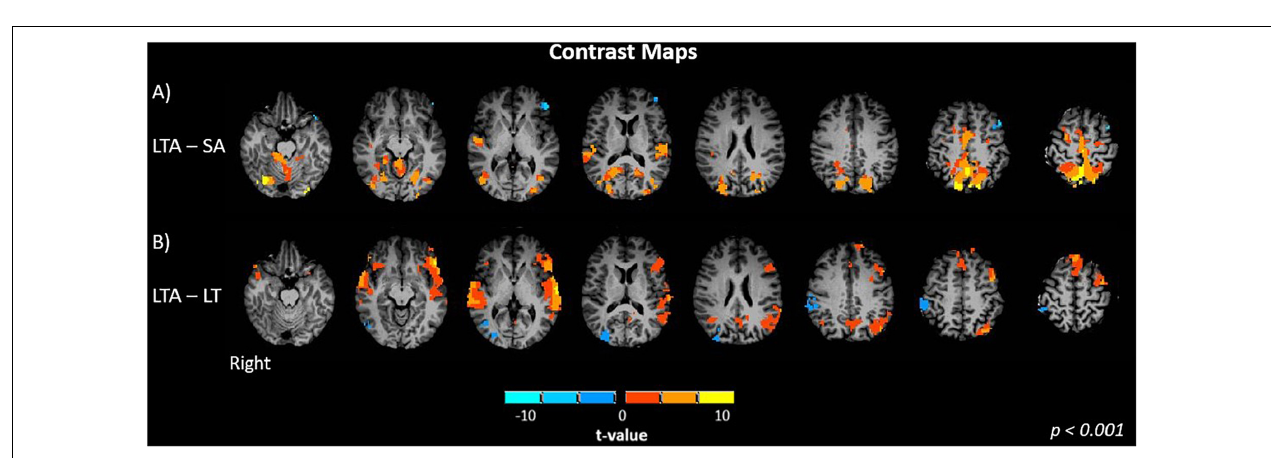
FIGURE 3 | Brain activations of participants when performing driving tasks while distracted. (A) SA, straight driving with audio task; (B) LTA, left turns with oncoming traffic and audio. Activations are shown as t contrasts in comparison with straight driving, and are reported with a statistical significance threshold of p < 0.001. “Right” indicates the right cerebral hemisphere.